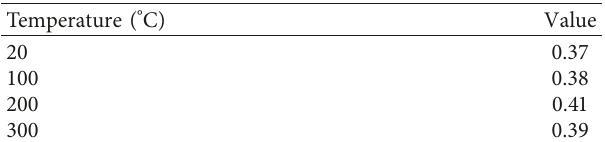
Table 5: The relationship between the friction coefficient and the temperature change.